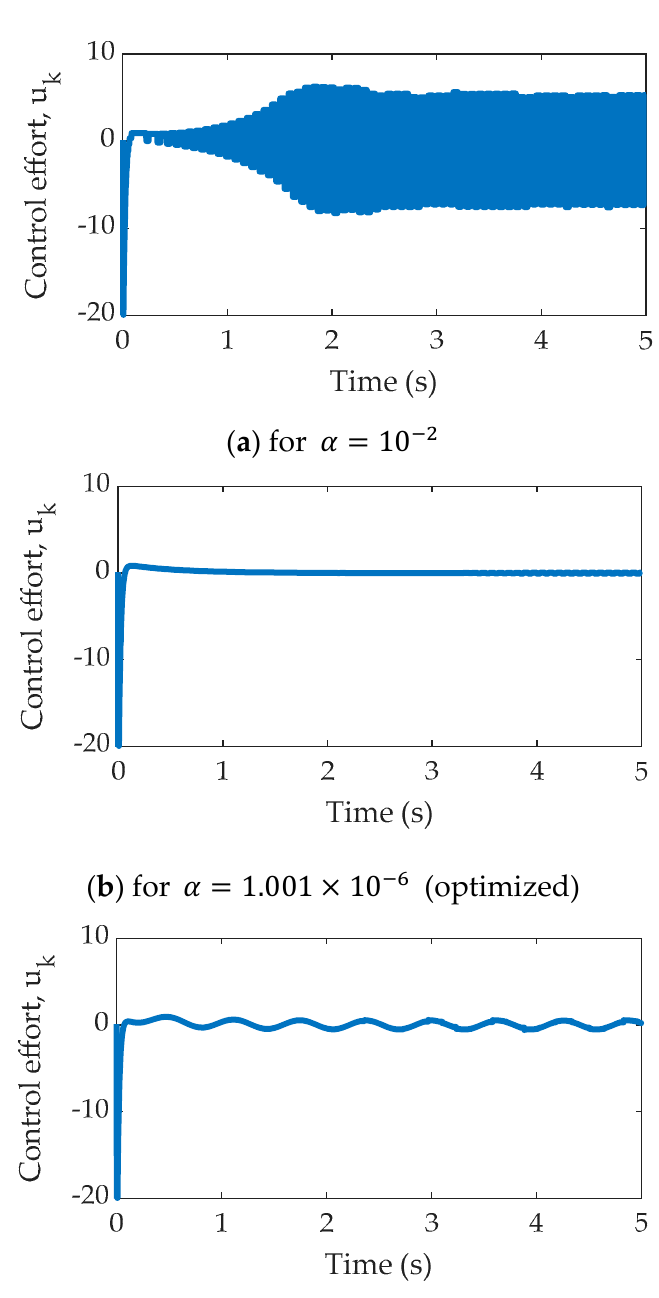
Figure 7. Control effort, u k .